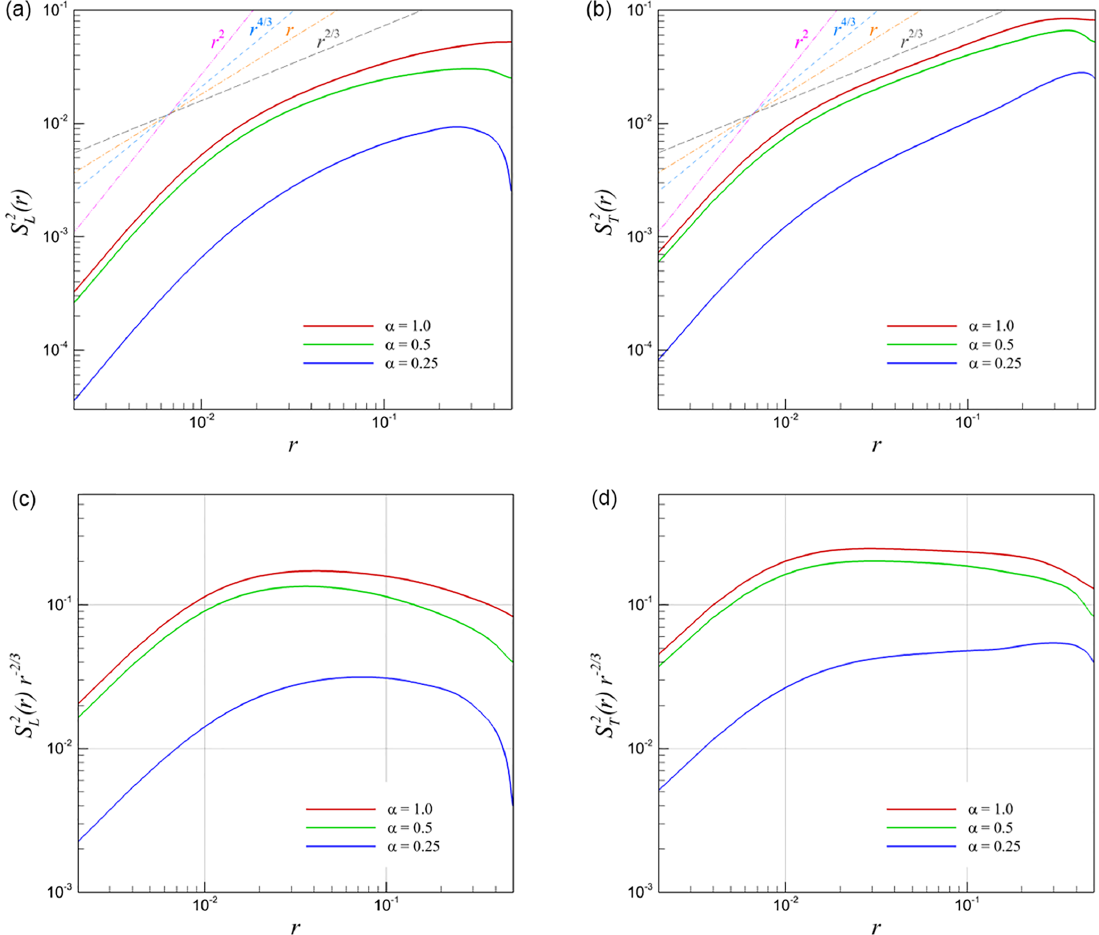
Figure 21. Second-order velocity structure functions for 3-D KHI turbulence. (a) Longitudinal structure function ( u (cid:107) r ), (b) transverse structure function ( u ⊥ r ), (c) compensated form of the longitudinal one, and (d) compensated form of the transverse